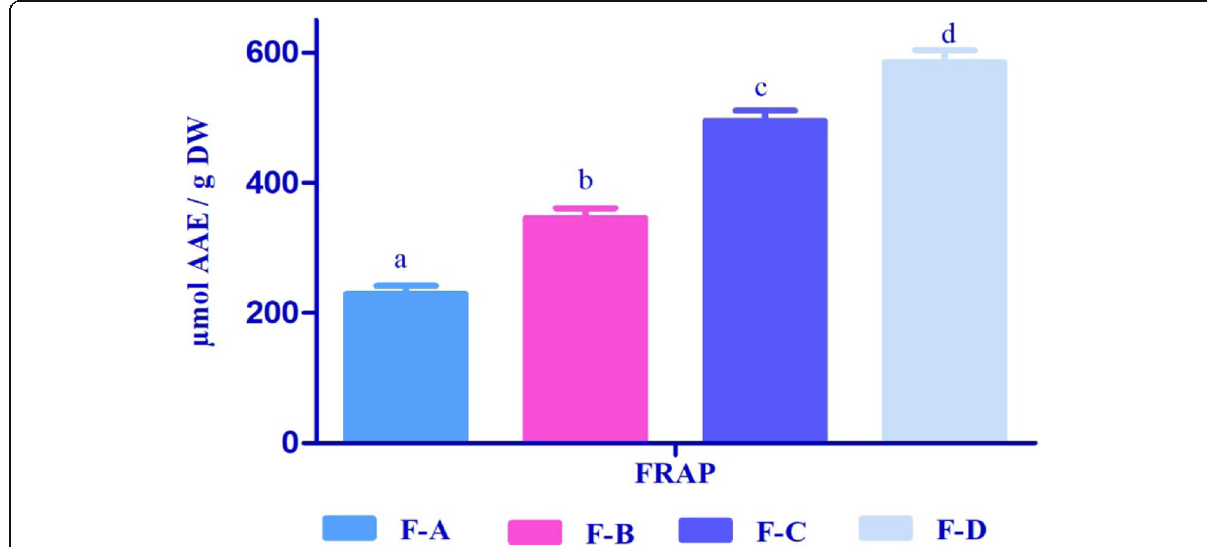
Fig. 4 FRAP activity in the isolated pooled fractions of MeCV. Each vertical bar represents mean ± SE for n = 3. The vertical bars having the same alphabet do not differ significantly, whereas the bars having the different alphabet differ significantly at P < 0.05 (one-way ANOVA followed by Tukey ’ s post hoc test)